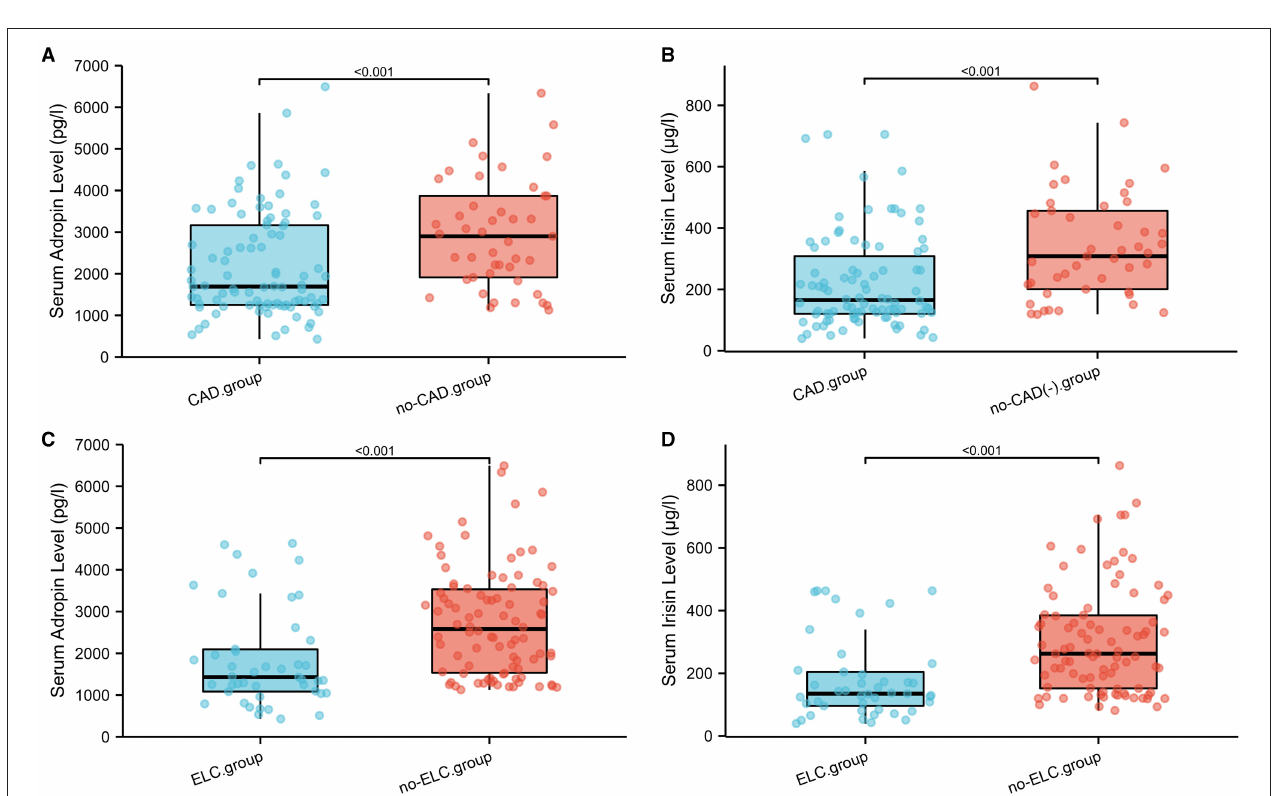
FIGURE 2 | (A–D) Comparison of serum adropin and irisin levels in subgroup analysis on the basis of CAD and ELC. ELC, earlobe crease; CAD, coronary artery disease.